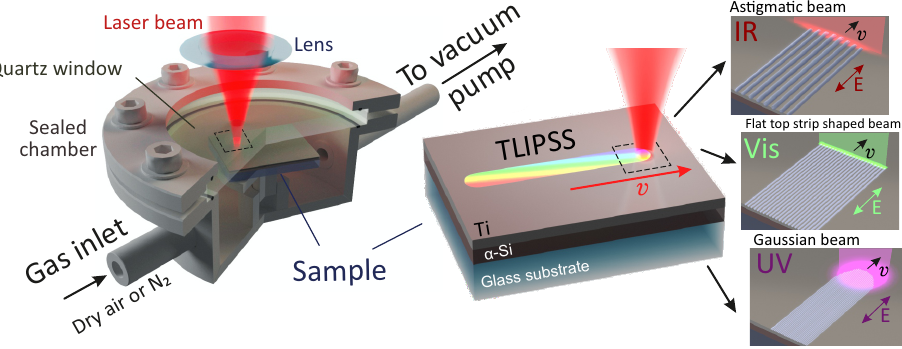
Figure 1. Schematically illustrated experimental setup for the TLIPSS formation using IR, visible and UV fs-laser